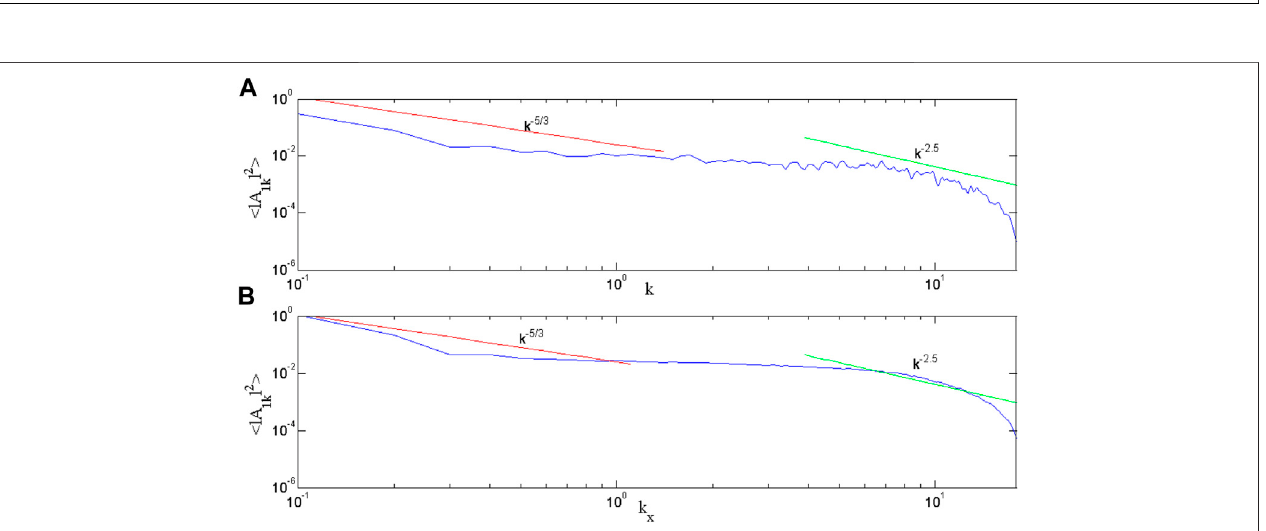
FIGURE 14 | Normalized saturated average wave number spectrum of DAW showing the distribution of energy over length scales when magnetic islands and background density perturbations are existing. In the fi gure, we plot (A) 〈 | A 1 k | 2 〉 / A 2 n versus k (cid:2) i.e.,betweenz=24andz=32and (B) 〈 | A 1 k | 2 〉 / A 2 n versusthewavenumberk x (normalizedby λ i )usingsevenspectra,i.e.,betweenz=25andz=31. “